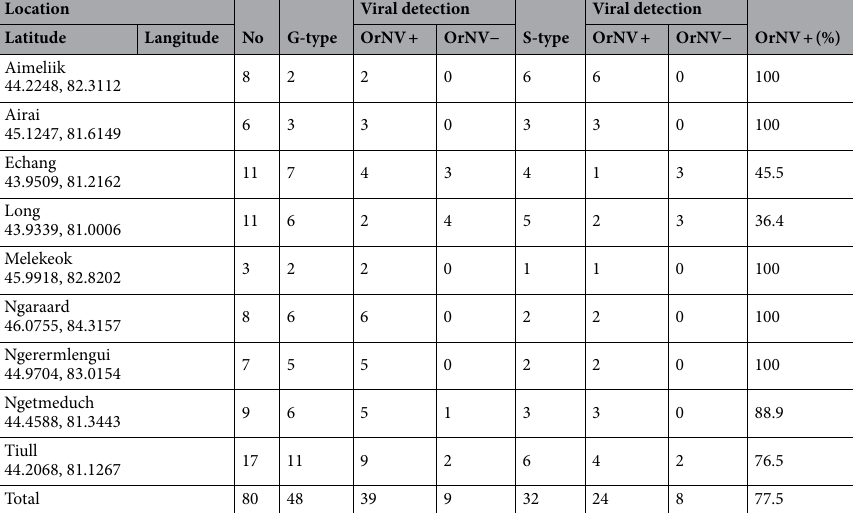
Table 1. Haplotype and detection of virus in Oryctes rhinoceros adults captured in the Palau Archipelago. (1) Number of adults examined. (2) OrNV + : Number of samples showed OrNV-positive detection by PCR, OrNV−: Number of samples showed OrNV-negative detection by